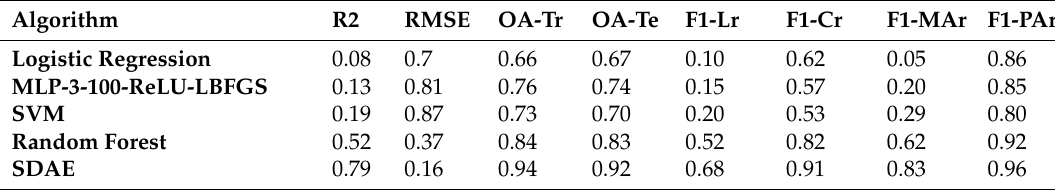
Table 6. Classification results for Paris.